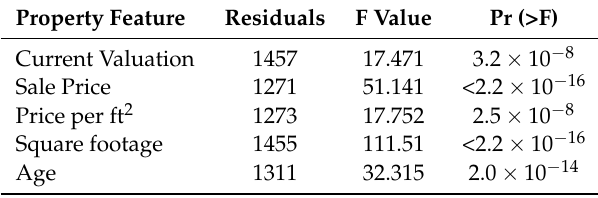
Table A1. Hit rates of first and second-order pairs of subjects in delineated neighborhoods.